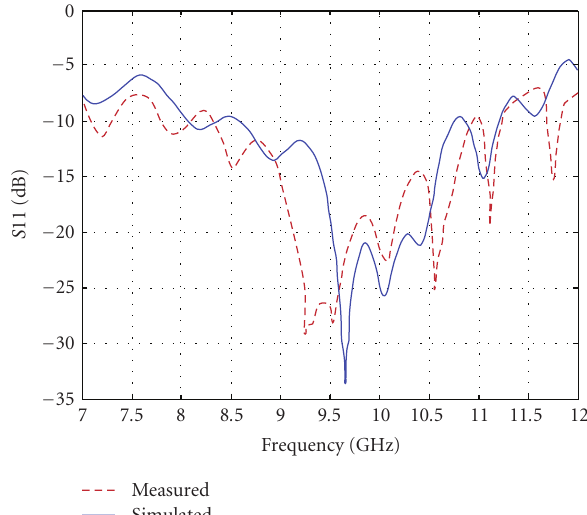
Figure 14: Simulated return loss LWA type III with relative die- lectric constant 1.1.